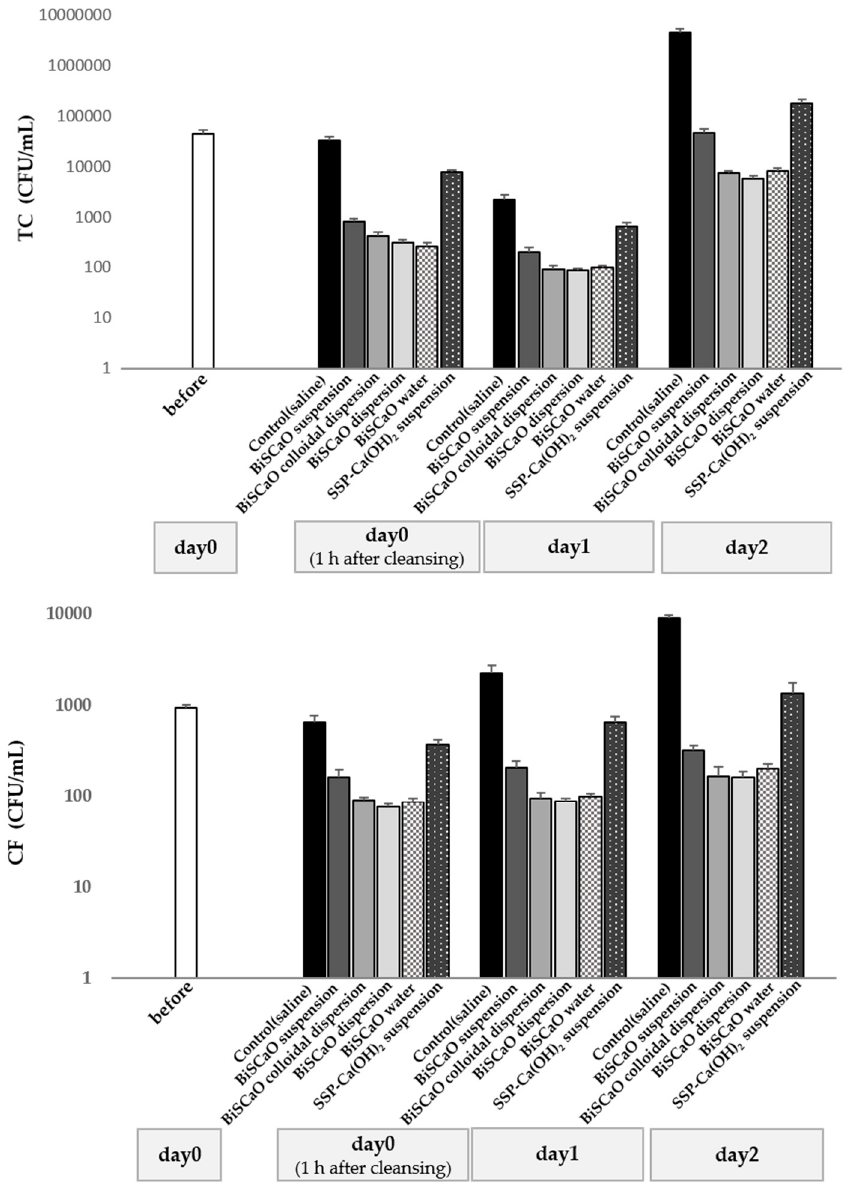
Figure 2. Anti-microbial e ffi cacy of BiSCaO-based disinfectants. The number of CFU / mL of TC ( upper ) and CF ( lower ) in 1 g of raw Japanese horse mackerel pre-incubated with saline at 10 ◦ C for 3 days was counted 1 h, 1 day, and 2 days after cleaning with each BiSCaO disinfectant and vigorously vortexing with 10 mL of pure water for 30 s ( n = 3). Pure water was used as the control.